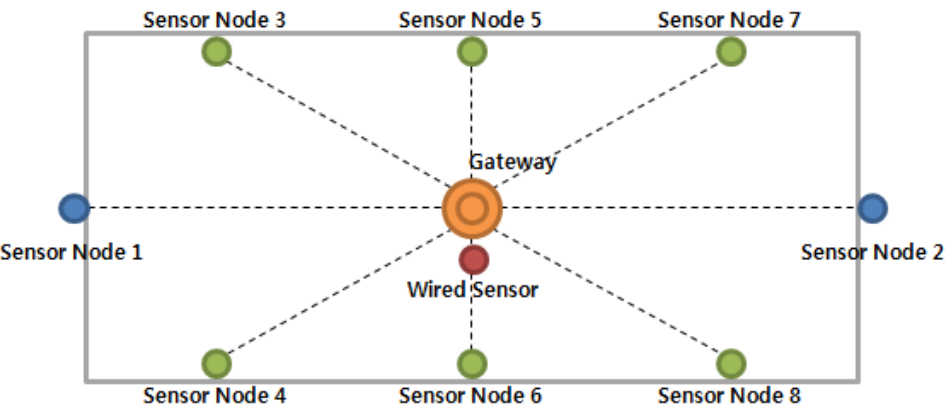
Figure 18. Wireless Sensor Network Topology.